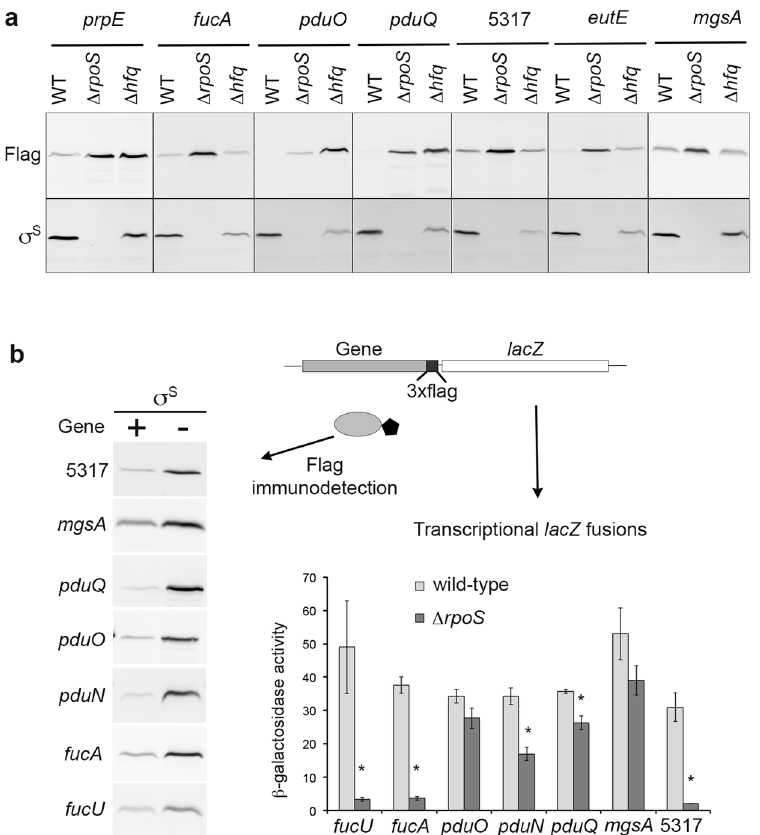
Figure 6. Post-transcriptional down-regulation of genes involved in metabolic functions. ( a ) Immunodetection of the 3xFlag-tagged proteins of interest was performed with an anti-Flag antibody in stationary phase (OD 600 of 4) LB cultures of the wild type, Δ rpoS , and Δ hfq strains (VF6910, VFC331 and VFA714, respectively). The amount of proteins in whole-cell lysates was determined and 20 μ g of total proteins were loaded in each slot. Reversible Ponceau staining of the membrane was used to check proteins transfer. Coomassie blue–stained gels of identical protein samples are shown in Supplementary Fig. S13. ( b ) Schematic representation of constructs used to assess expression of transcriptional lacZ fusions in the indicated genes, and production of the corresponding 3xFlag-tagged proteins, in stationary phase (OD 600 of 4) LB cultures the wild type and Δ rpoS strains (VF6910 and VFC331, respectively). Left: Immunodetection of 3xFlag-tagged proteins. The amount of proteins in whole-cell lysates was determined and 20 μ g of total proteins were loaded in each slot. Reversible Ponceau staining of the membrane was used to check proteins transfer. Coomassie blue–stained gels of identical protein samples are shown in Supplementary Fig. S13. Right: β -galactosidase assays. Bar graphs represent the mean β -galactosidase activity, and error bars represent standard deviation of at least three independent experiments. * β -galactosidase activity in the Δ rpoS mutant significantly different from that in the wild-type strain (p < 0.05, two-tailed t